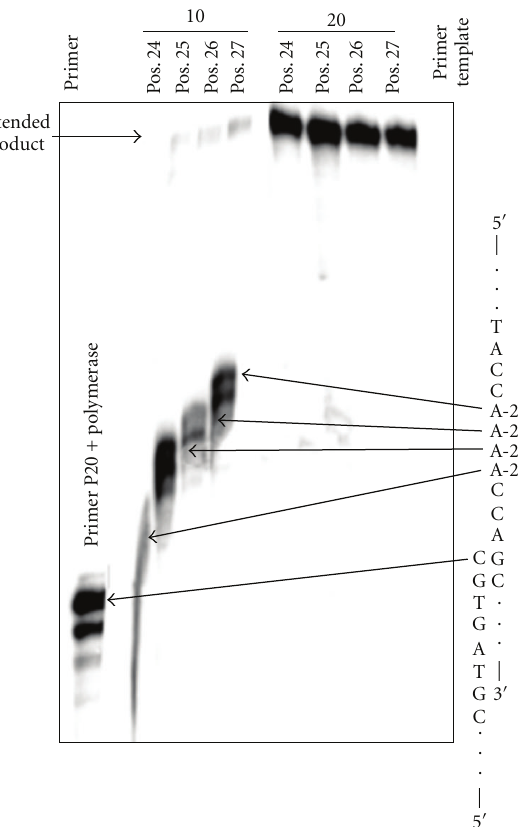
Figure 10: The e ff ect of the position of the THF abasic site lesion within the A 4 tract on the insertion and extension by Pol η . Templates containing THF abasic site at di ff erent positions within the A-tract were synthesized and extended using yeast Pol η for 10 to 20 minutes in the presence of 100 μ M dNTPs. In the 10 minutes incubation, the formation of extended product is dependent on the position of the THF lesion. E ffi cient by-pass of the lesion is observed with the longer incubation